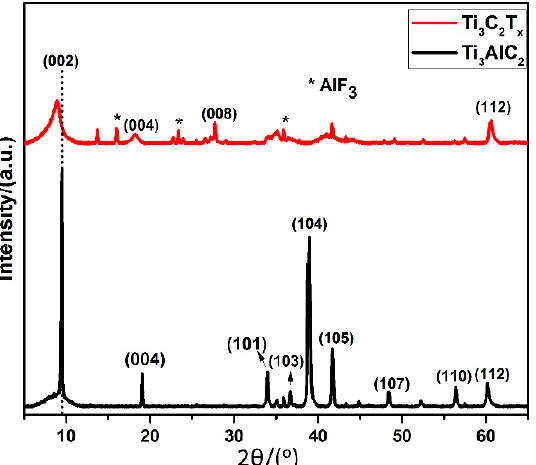
Figure 1. XRD patterns of Ti 3 AlC 2 MAX precursor and as-synthesized Ti 3 C 2 T x Mxene. Peaks marked with * are assigned AlF 3 phase.